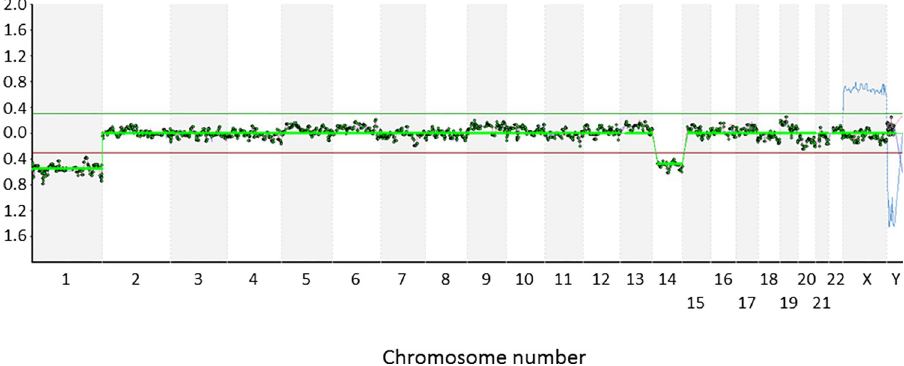
Fig 1. Microarray-CGH analysis of an embryo from a Robertsonian translocation carrier. Cytogenetic analysis of a cleavage stage embryo from a Robertsonian translocation carrier- 46,XY,t(13;14). Microarray-CGH revealed monosomy 14, presumably resulting from a meiotic error due to problems processing the rearranged chromosomes. An additional aneuploidy unrelated to the Robertsonian translocation (monosomy for chromosome 1) was also detected. The two monosomies are indicated by the altered ratio of fluorescence related to the test (embryo) and reference (46,XY) DNA samples. All of the probes corresponding to chromosomes 1 and 14 have test/reference ratios less than